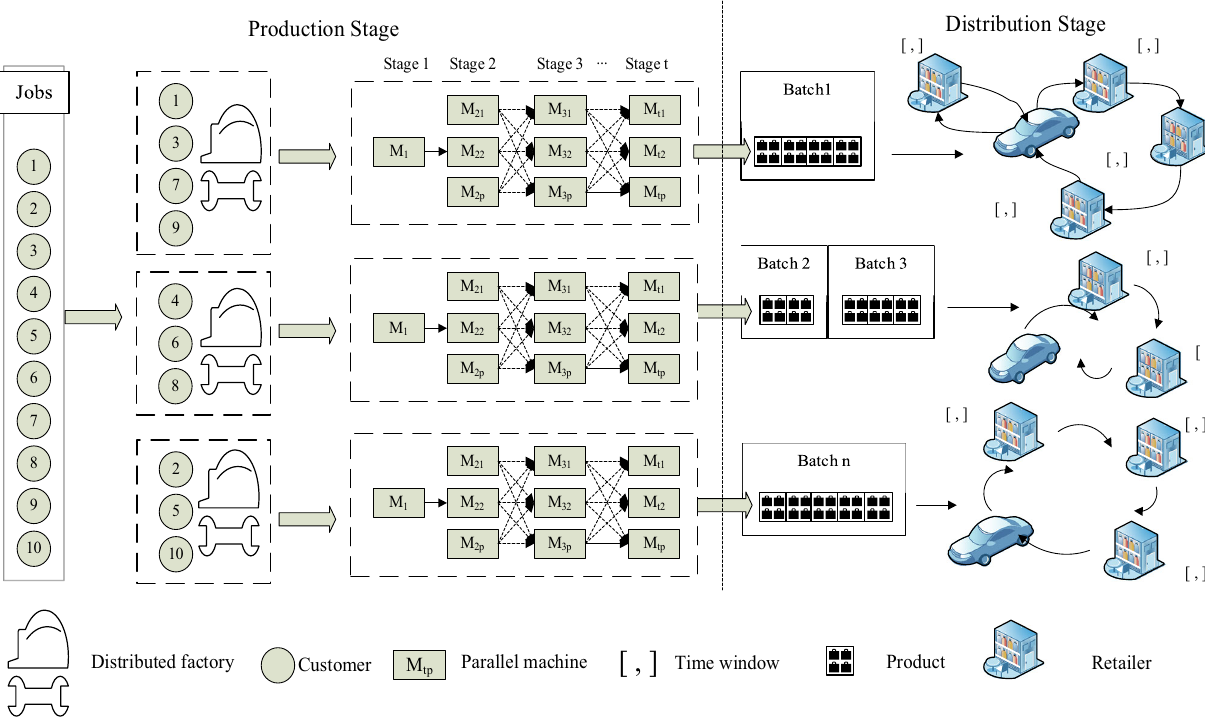
Fig. 1 Integrated production and distribution in group manufacturing